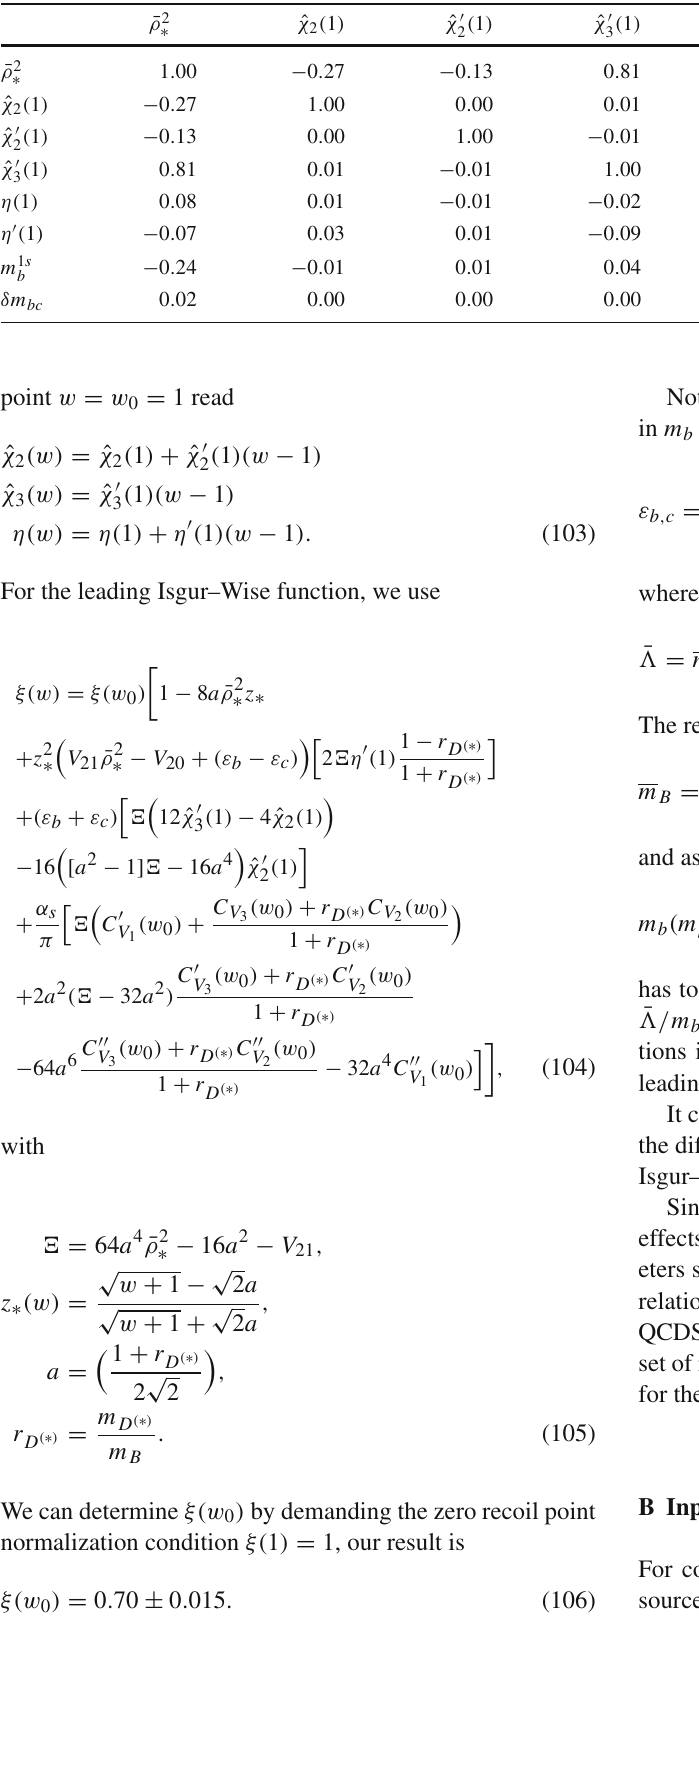
Table 18 Correlation matrix for the input parameters used to calculate the HQET form factors for the B → D ( ∗ ) (cid:2) ¯ ν (cid:2)